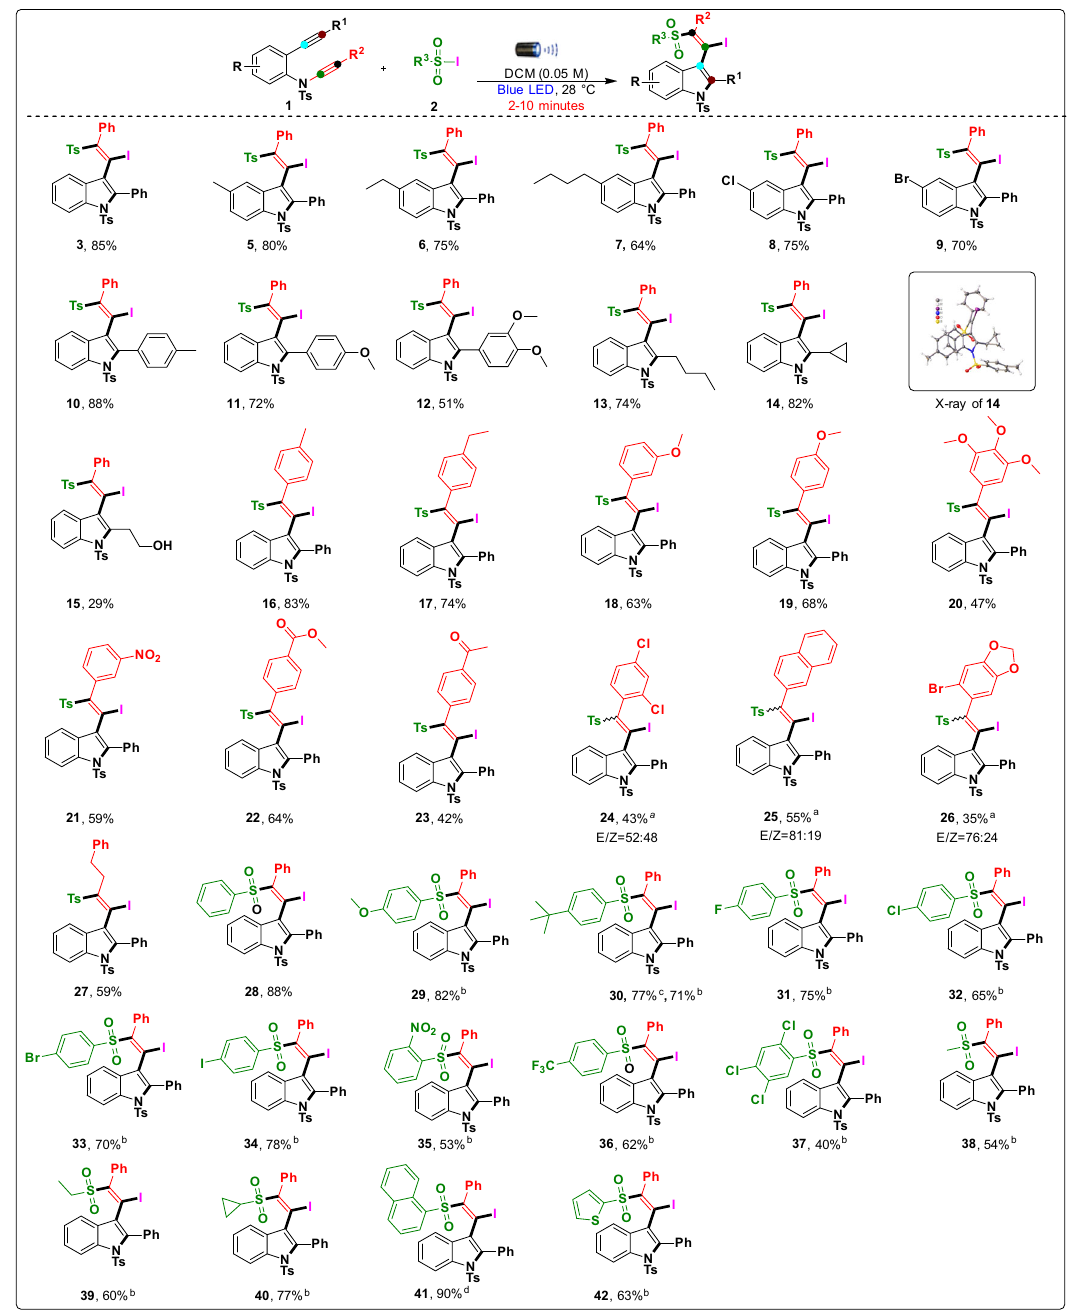
Fig. 3 Substrate scope for the 2-alkynyl-ynamides, sulfonyl iodide, and sulfonyl hydrazides. Reaction conditions: 1 (0.10 mmol), 2 (sulfonyl